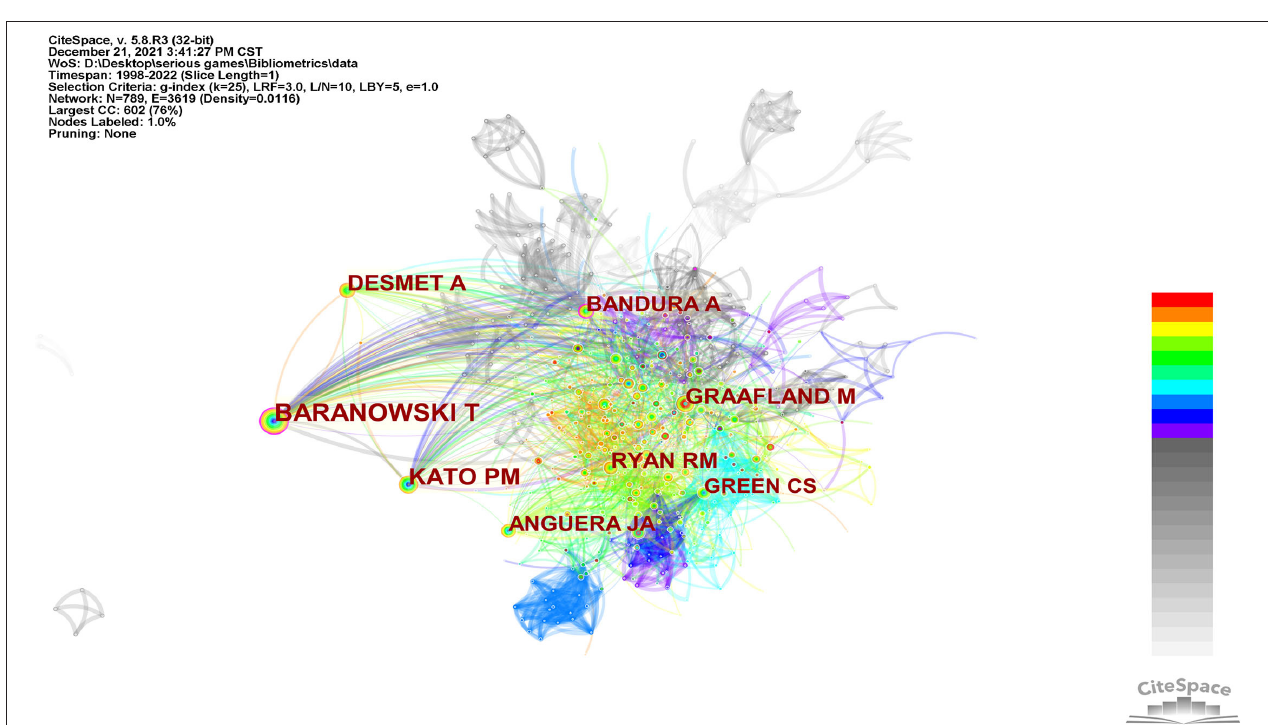
FIGURE 3 | Author collaboration